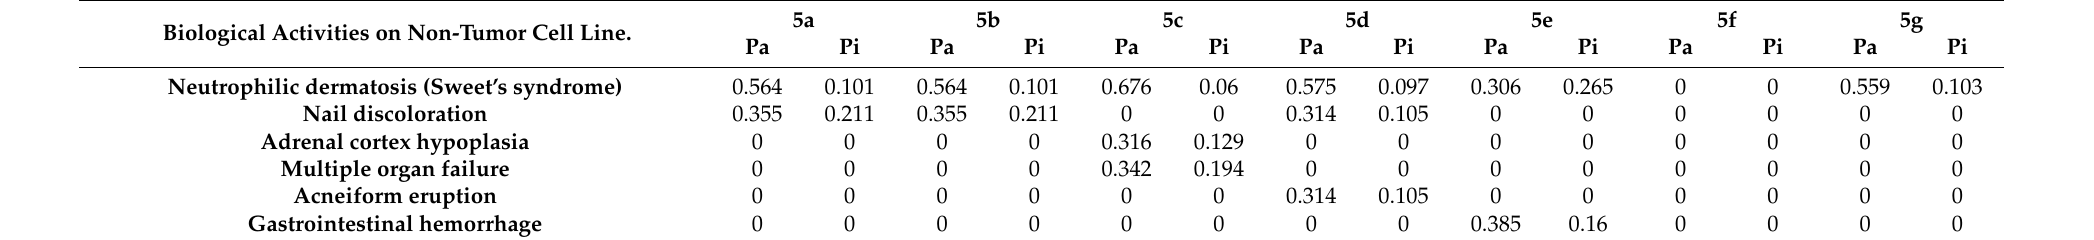
Table 5. The predicted activities of the SBs, 5a – g on non-tumor cell lines using PASS at Pa > Pi. Biological Activities on Non-Tumor Cell